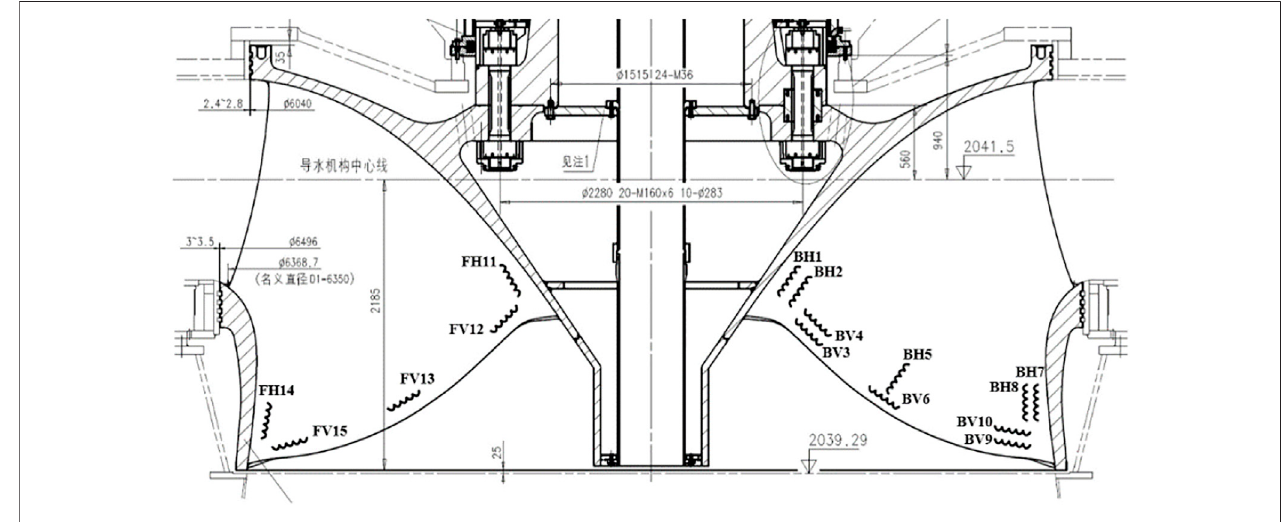
FIGURE 4 | The layout of the strain gauges for Francis turbine runner.